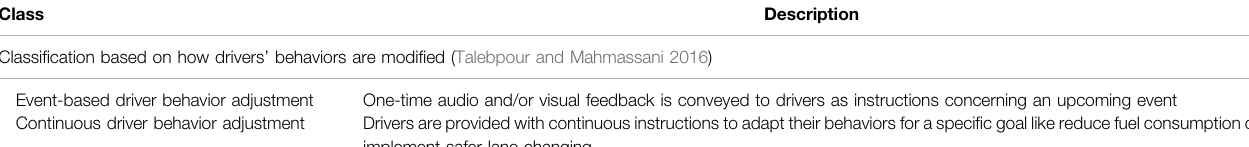
Event-based driver behavior adjustment